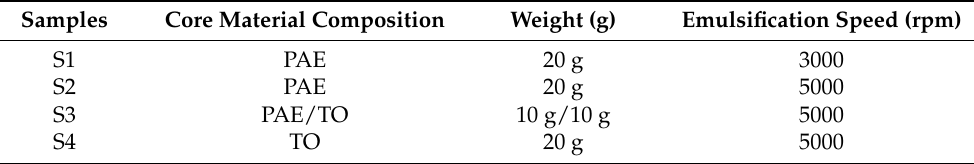
Table 2. Synthetic parameters of microencapsulated amine with MF resin